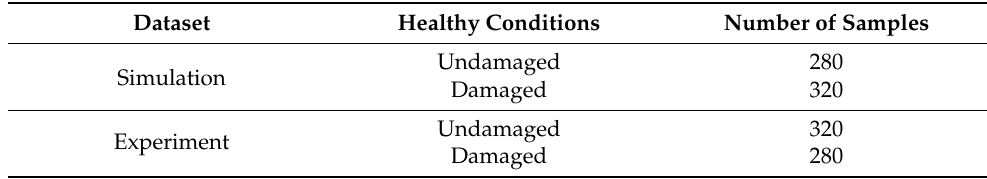
Table 2. Introduction to